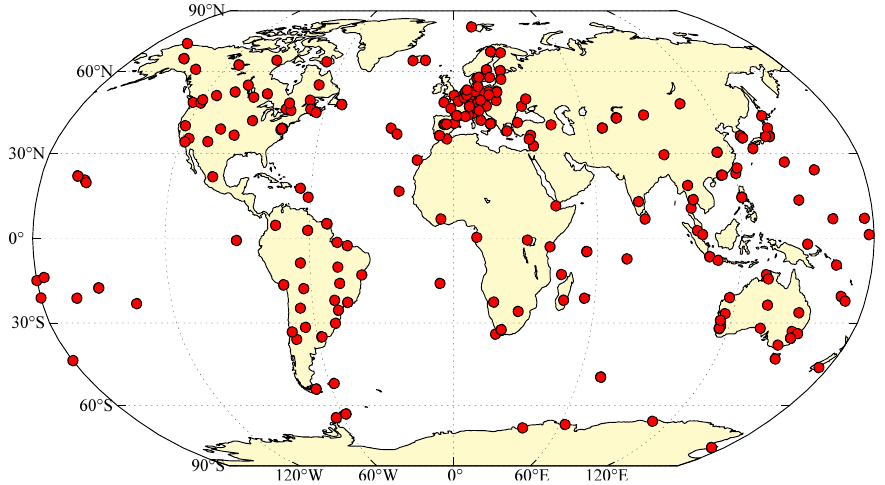
Figure 2. Distribution map of GNSS monitoring stations.